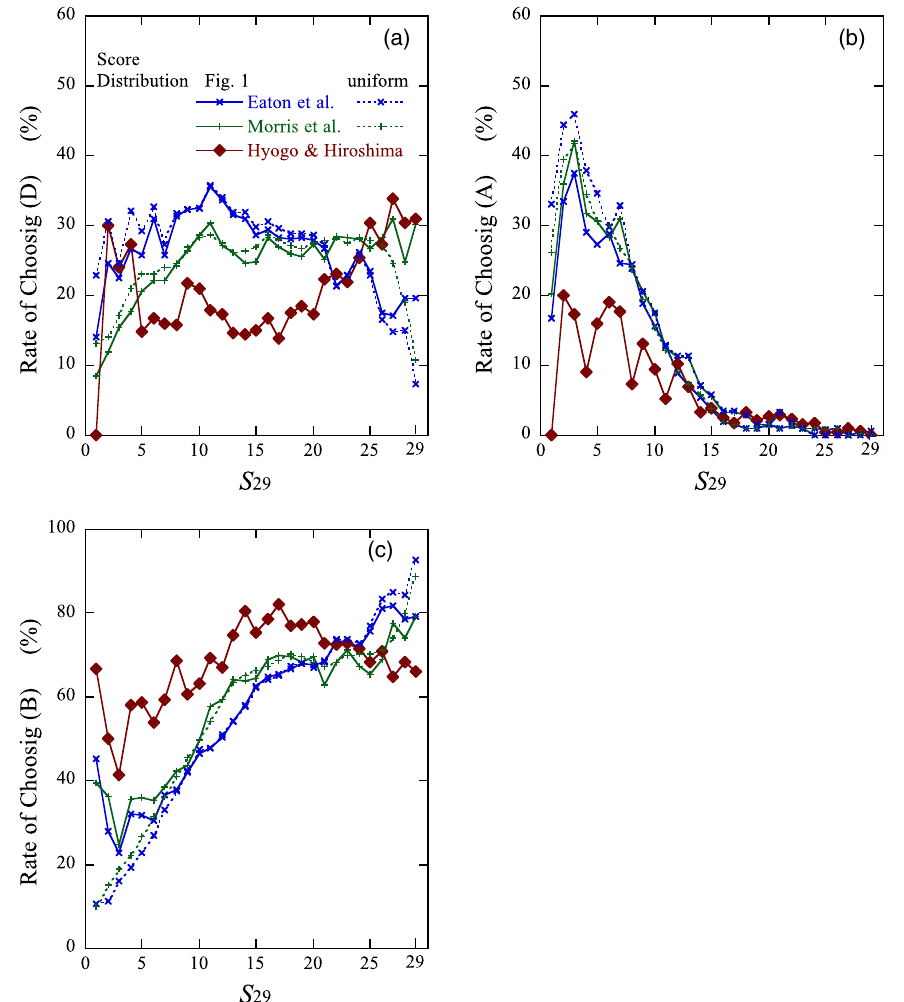
FIG. 5. Comparison of MIRCs obtained in Hyogo and Hiroshima with two MIRCs obtained in the U.S. The MIRCs in the U.S. were transformed from normal IRCs using a score distribution similar to Fig. 1 (solid lines) and the uniform distribution (broken